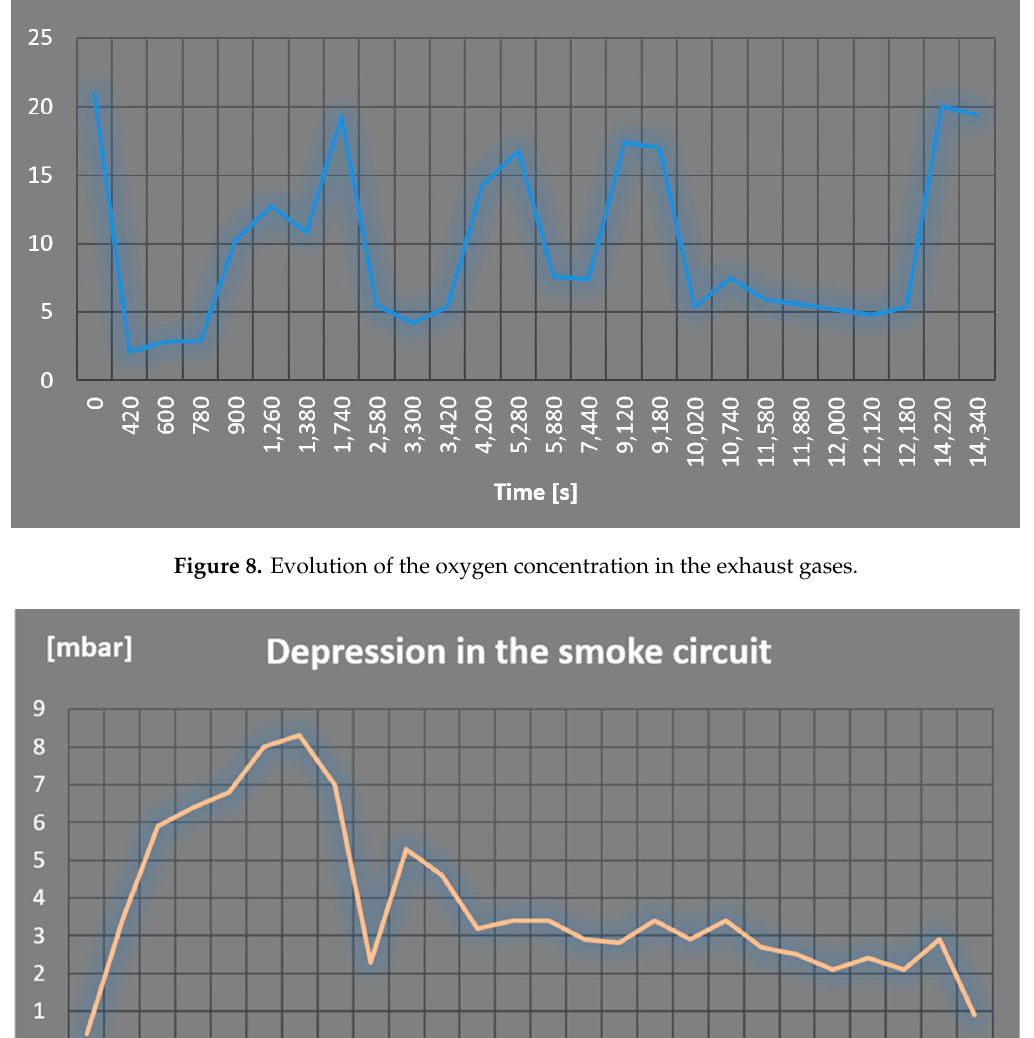
Figure 7. Trend of the temperature of the cement that surrounds the combustion chamber.